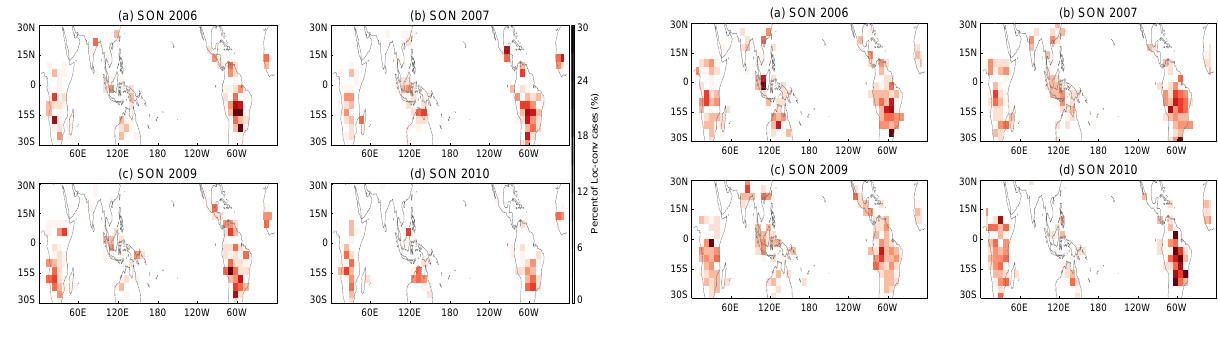
Fig. 10. Spatial distributions of the average increase of CO associ- ated with the “local convection” transport pathway within each 4 ◦ latitude × 8 ◦ longitude grid box during (a) SON 2006, (b) SON 2007, (c) SON 2009 and (d) SON 2010.